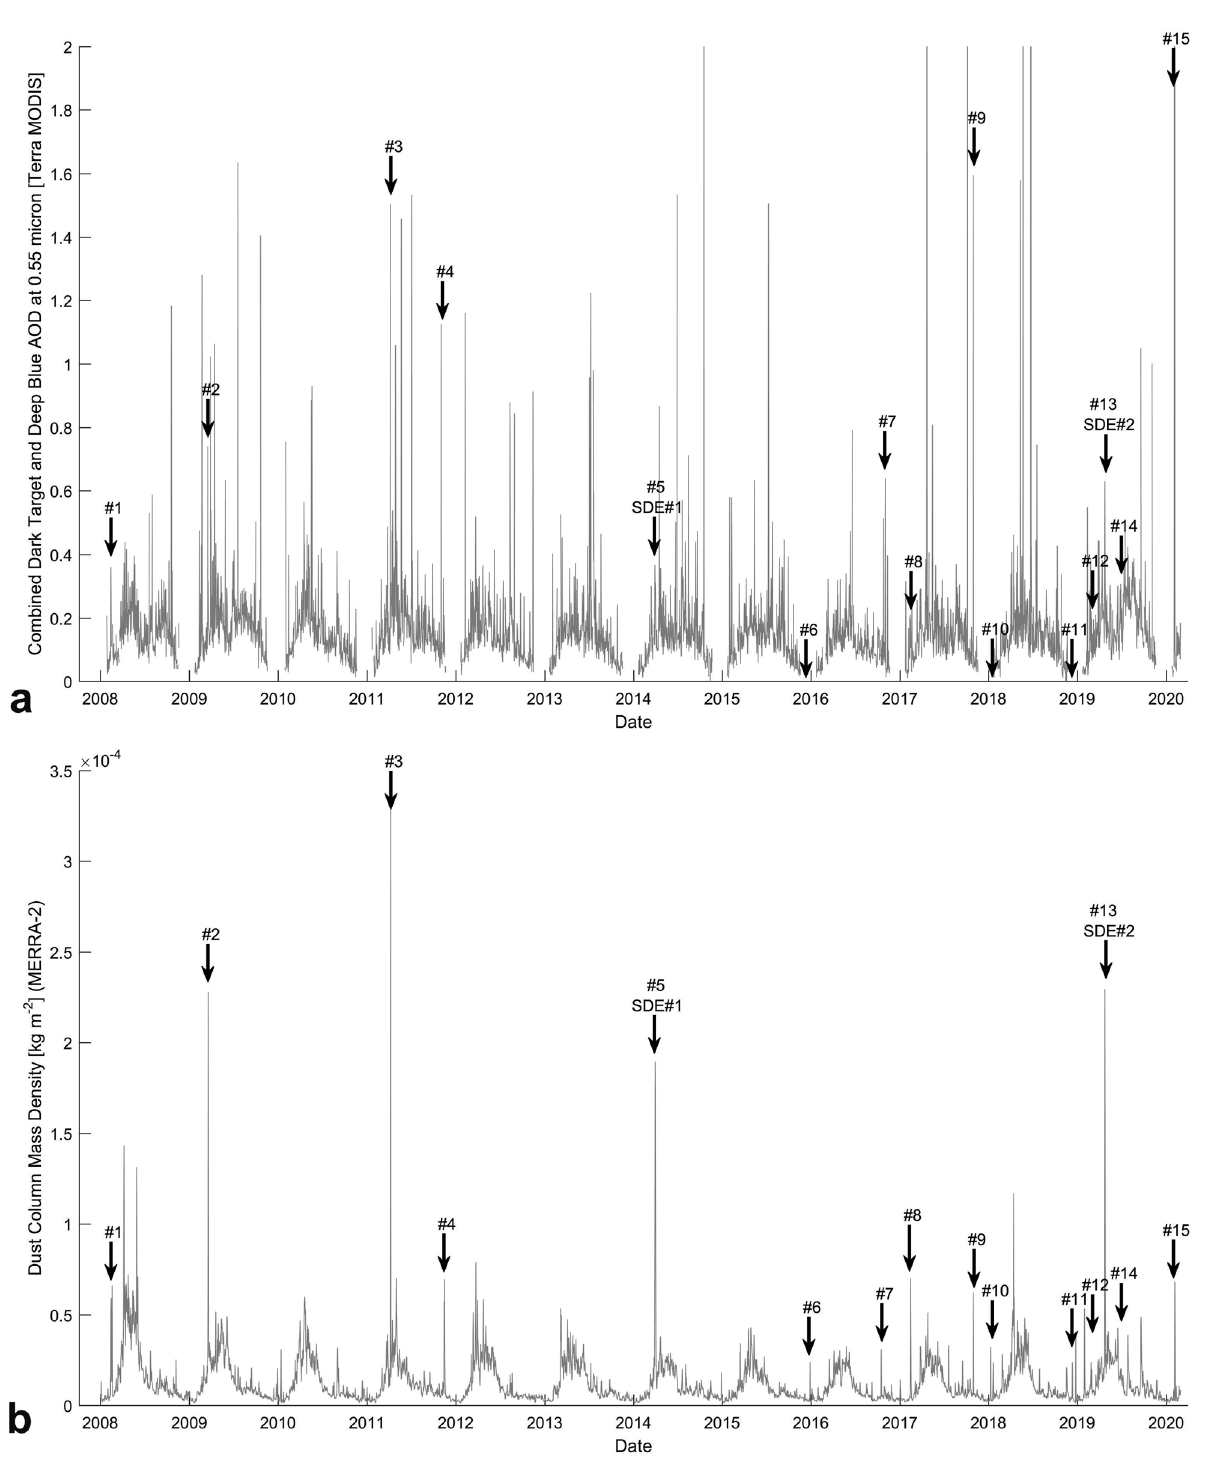
Figure 1. Aerosol optical depth data ( a ) and MERRA-2 dust column mass density data ( b ) of the study area and the identified Saharan dust events